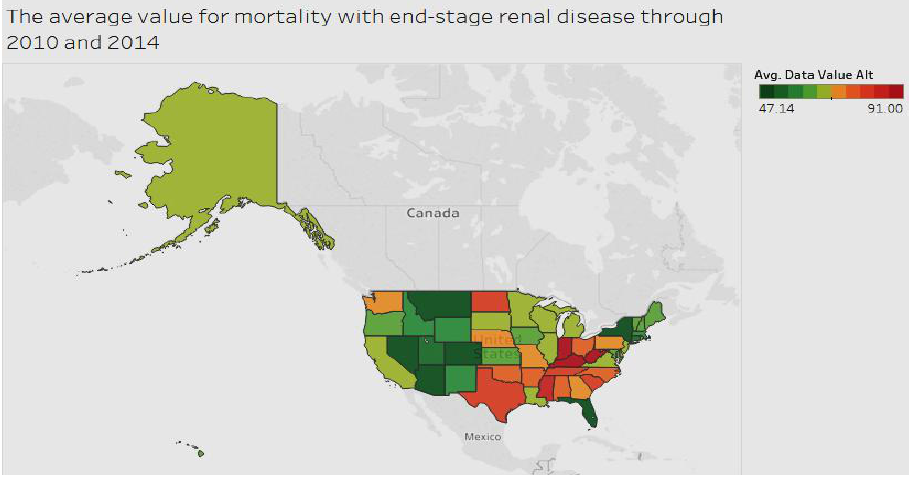
Figure 4. End-stage renal disease by region.